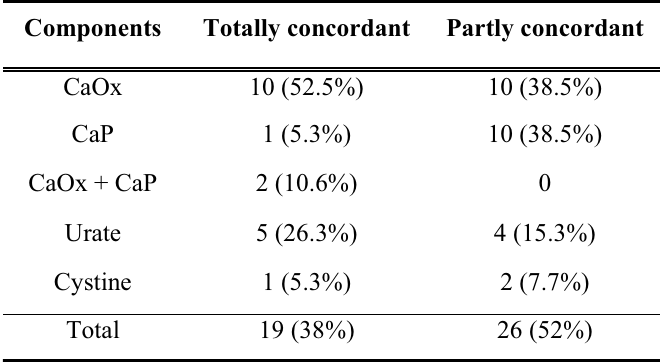
TABLE 3 - Agreement between chemical and morphological findings for 50 kidney